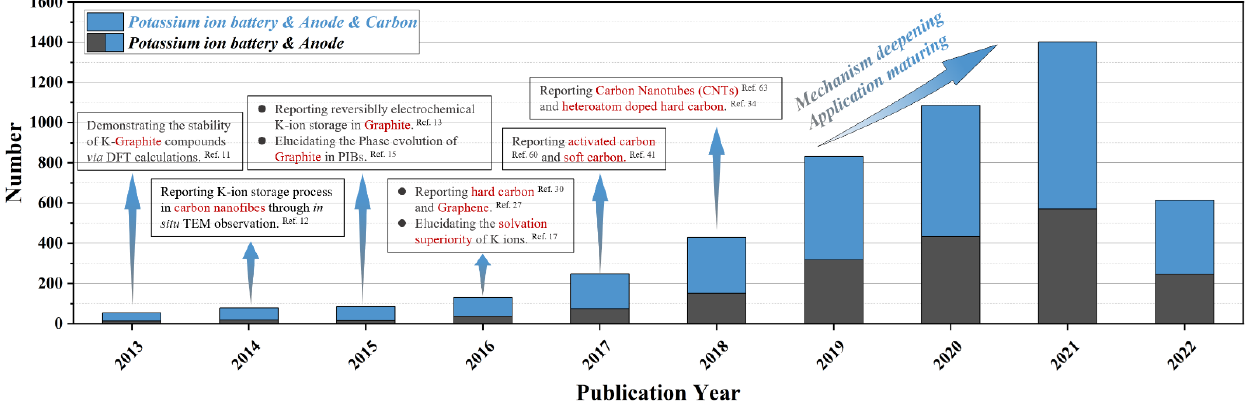
Figure 1. Number of publications. Data were collected by searching “Potassium ion battery & An- ode & Carbon” and “Potassium ion battery & Anode” in Web of Science on 23 July 2022